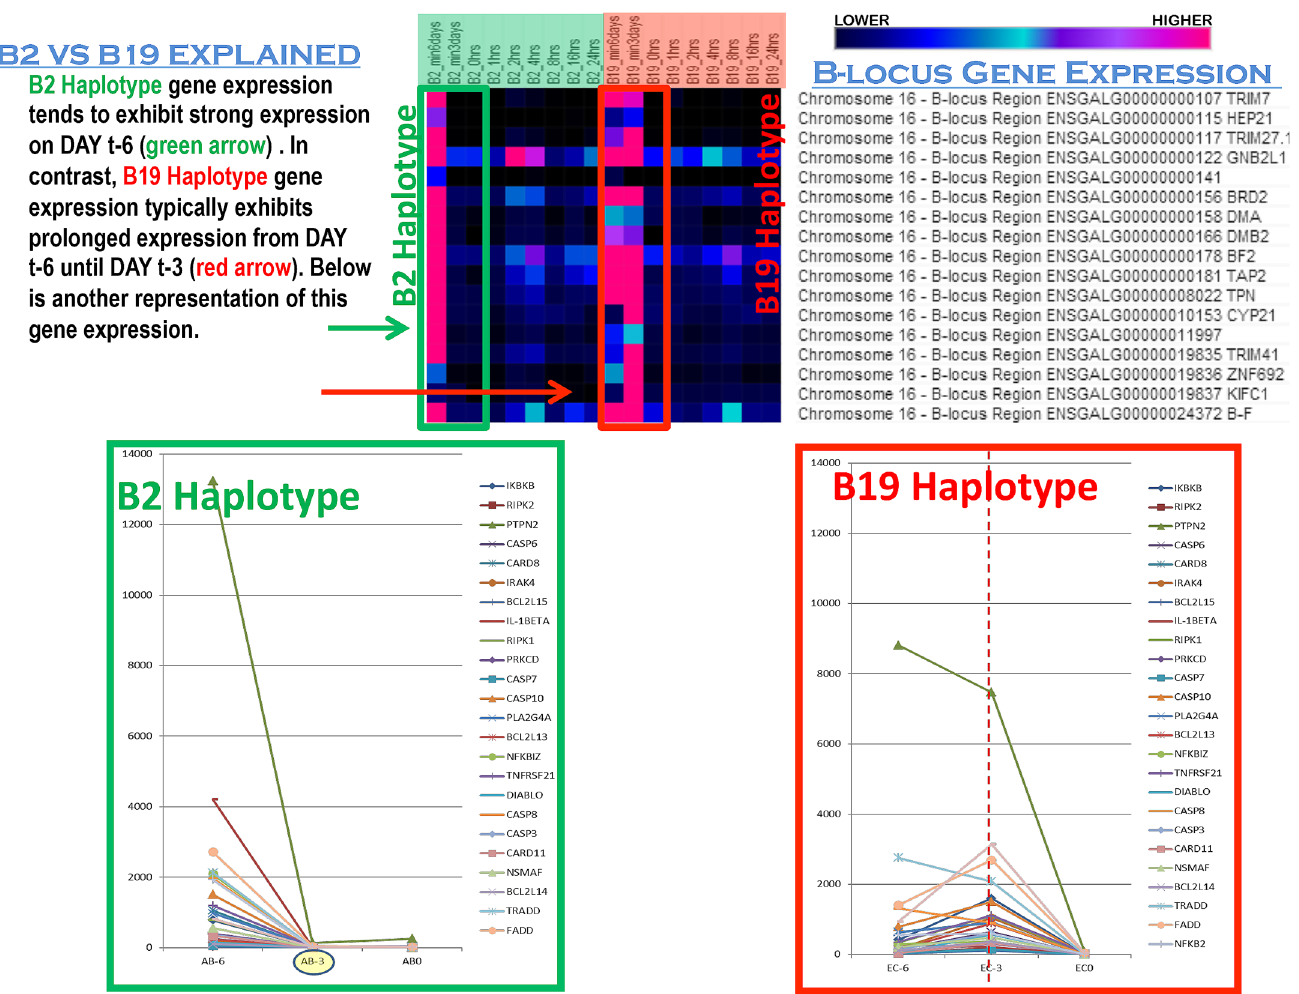
Fig 2. Distinct temporal gene expressionpatterns in B2 versus B19 monocytes/macrophages. B-locus haplotypes in chickens provide a mechanismfor genetically perturbingthe cluster of immunologically important genes on chromosome 16 and producingphenotypic variation affecting infectiousdisease susceptibility and resistance.The heat map allows visualization of gene expressionbetweenthe two geneticallydistinct haplotypes. Each row represents a gene within the B-locus (listed on the right) and each column corresponds to a particular time point when cells were collectedfor RNA sequencing. Black pixels indicatezero gene expressionfor a particulargene at a specific point in time, and dark blue correspondsto very low expression, while brighter blue indicatesthe next higherlevels. Dark purplerepresents higherexpressionlevels than blue colors, and pink represents the highest levels of gene expression. Monocytes were obtainedfrom each haplotypeof chicken and allowedto differentiateinto macrophages in vitro for seven, days beginning on day minus 6 (t-6). RNA was sampledon day t-6, day t-3, and again three days later which is denotedas 0 hours (t0), when IFN γ was initiallyadded to the cultures. On t0, RNA was sampledimmediately before stimulationwith IFN γ . Subsequent time points correspond to the time followinginterferonstimulation,in hours (1 hour, 2 hours, 4 hours, 8 hours, 16 hours and 24 hours). As visible on the heat map, there are distinct differencesin gene expressionbetweenthe B2 and B19 cells. The most dramatic difference occurs on day t-6. B2 cells exhibita rapid burst of gene expression, indicatedas a single column of pink on the left most edge of the heat map. In contrast, the B19 cells appearto undergoa much slower and prolongedgene expressionprogram that was not as rapidly down regulatedas in genesin the B2 cells. Additionalgene expressiondata for a numberof proteins involvedin cell growth and apoptosis,is shown in the bottom half of the figure to highlighta similar pattern in gene expressionand kinetics. The green border indicatesthe B2 haplotypeexpressionpattern and the red border corresponds to the B19 expressionpattern.